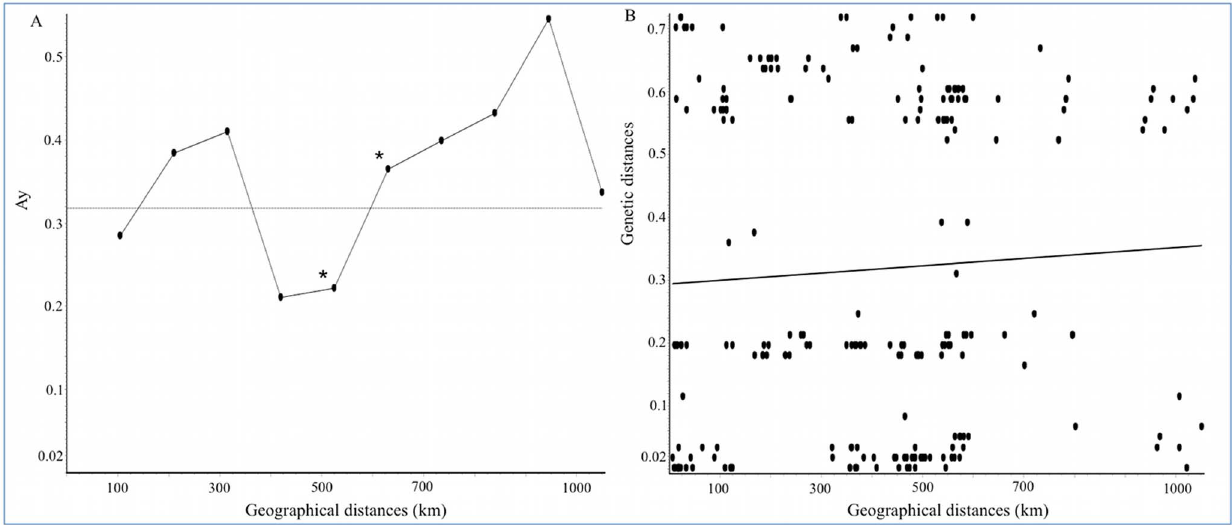
Figure 4. Distance-based analyses of population structure of T.dimidiata in Colombia. A) Distogram of spatial autocorrelation analysis of T. dimidiata from Colombia showing the relationship between pairwise genetic ND4 gene distances (y-axis) and geographical distances (m) in 10 spatial classes (x-axis). Horizontal line indicates the average value of Ay for the data set. Asterisk represents a significant ( p , 0.05) Miller autocorrelation index (Ay). B) Mantel test of genetic (ND4 gene) and geographical distances (m) between the geographical locations of T. dimidiata analyzed in this